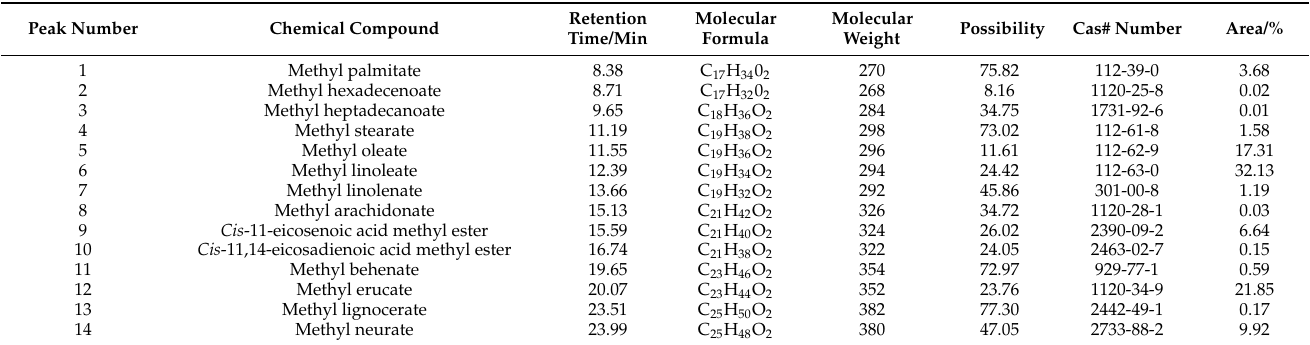
Table 2. Fatty acid methyl esters identified after methyl esterification of the A. truncatum